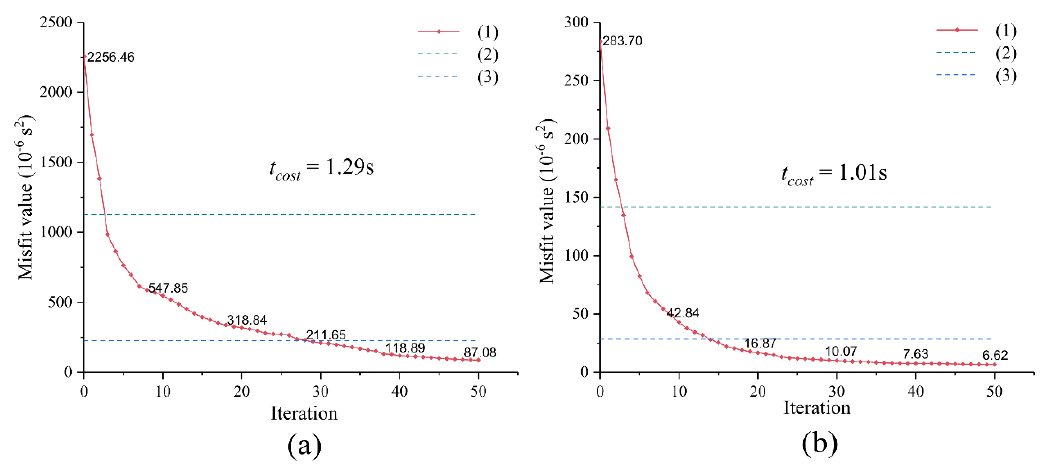
Figure 12. Convergence curves and operation time of ( a ) TDAT and ( b ) FAAT. Legend: (1) conver- gence curve; (2) 50% of the initial misfit function value; (3) 10% of the initial misfit function value.